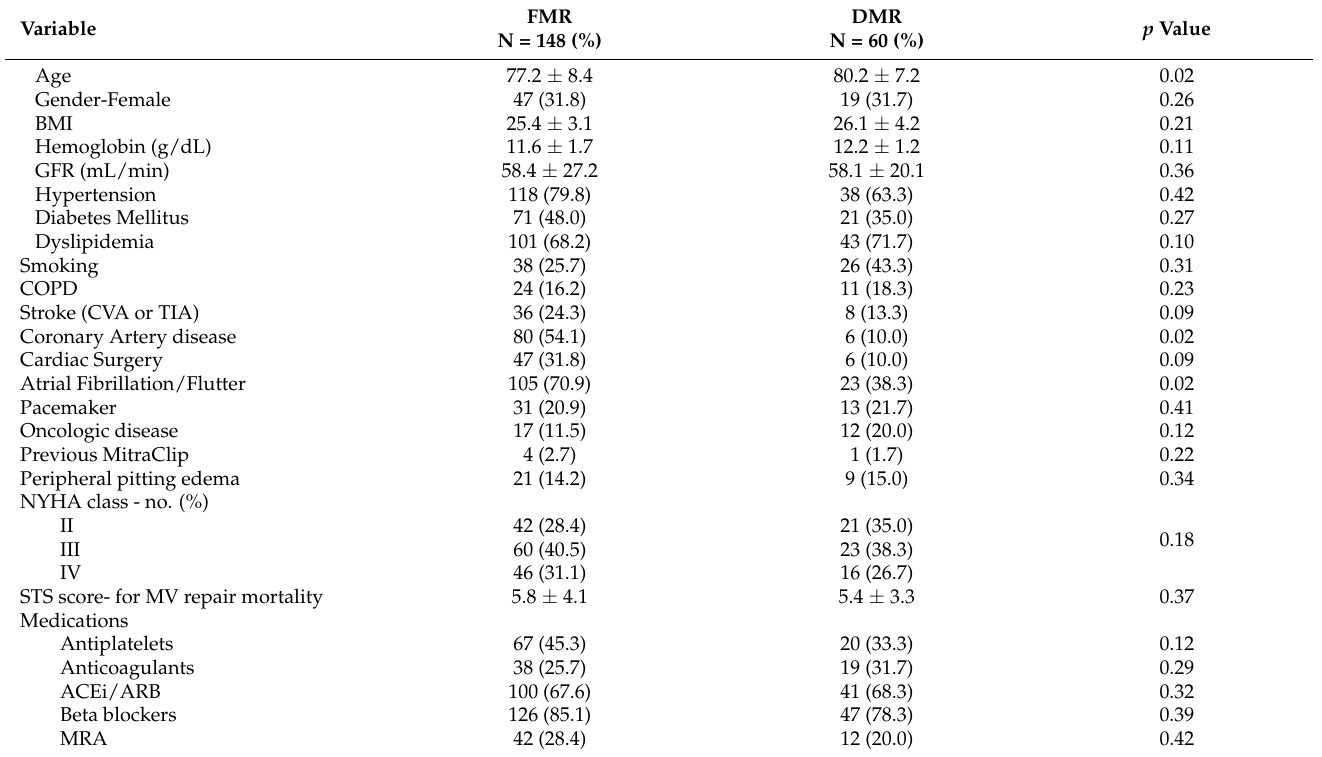
Table 1. Baseline